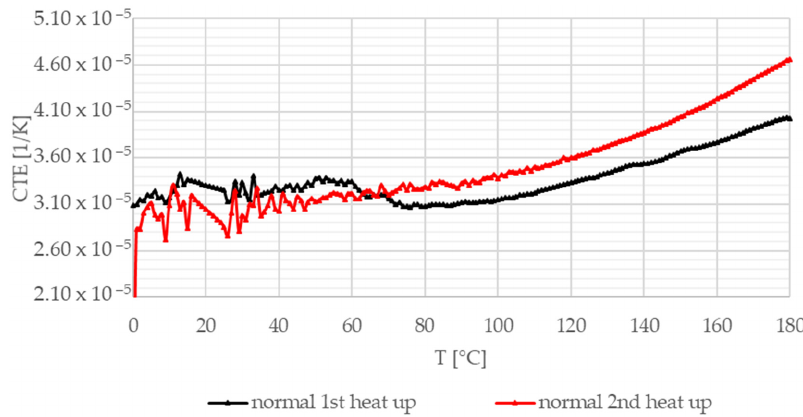
Figure 17. Coefficient of thermal expansion—tangential direction, two heat-up loops (black, red).